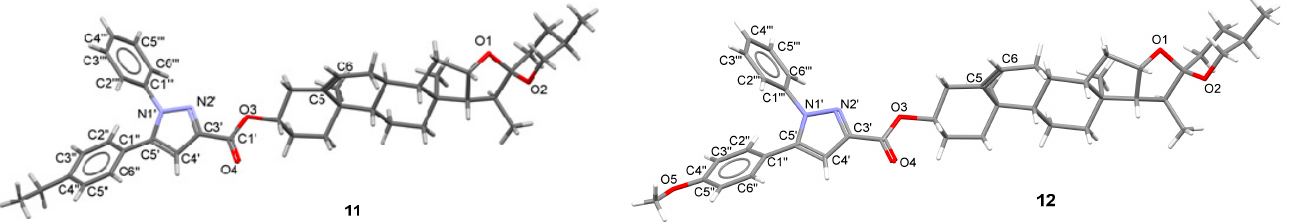
Figure 2. The molecular structure of steroidal pyrazoles 11 , 12 . The thermal ellipsoids are drawn at the 30% probability level.